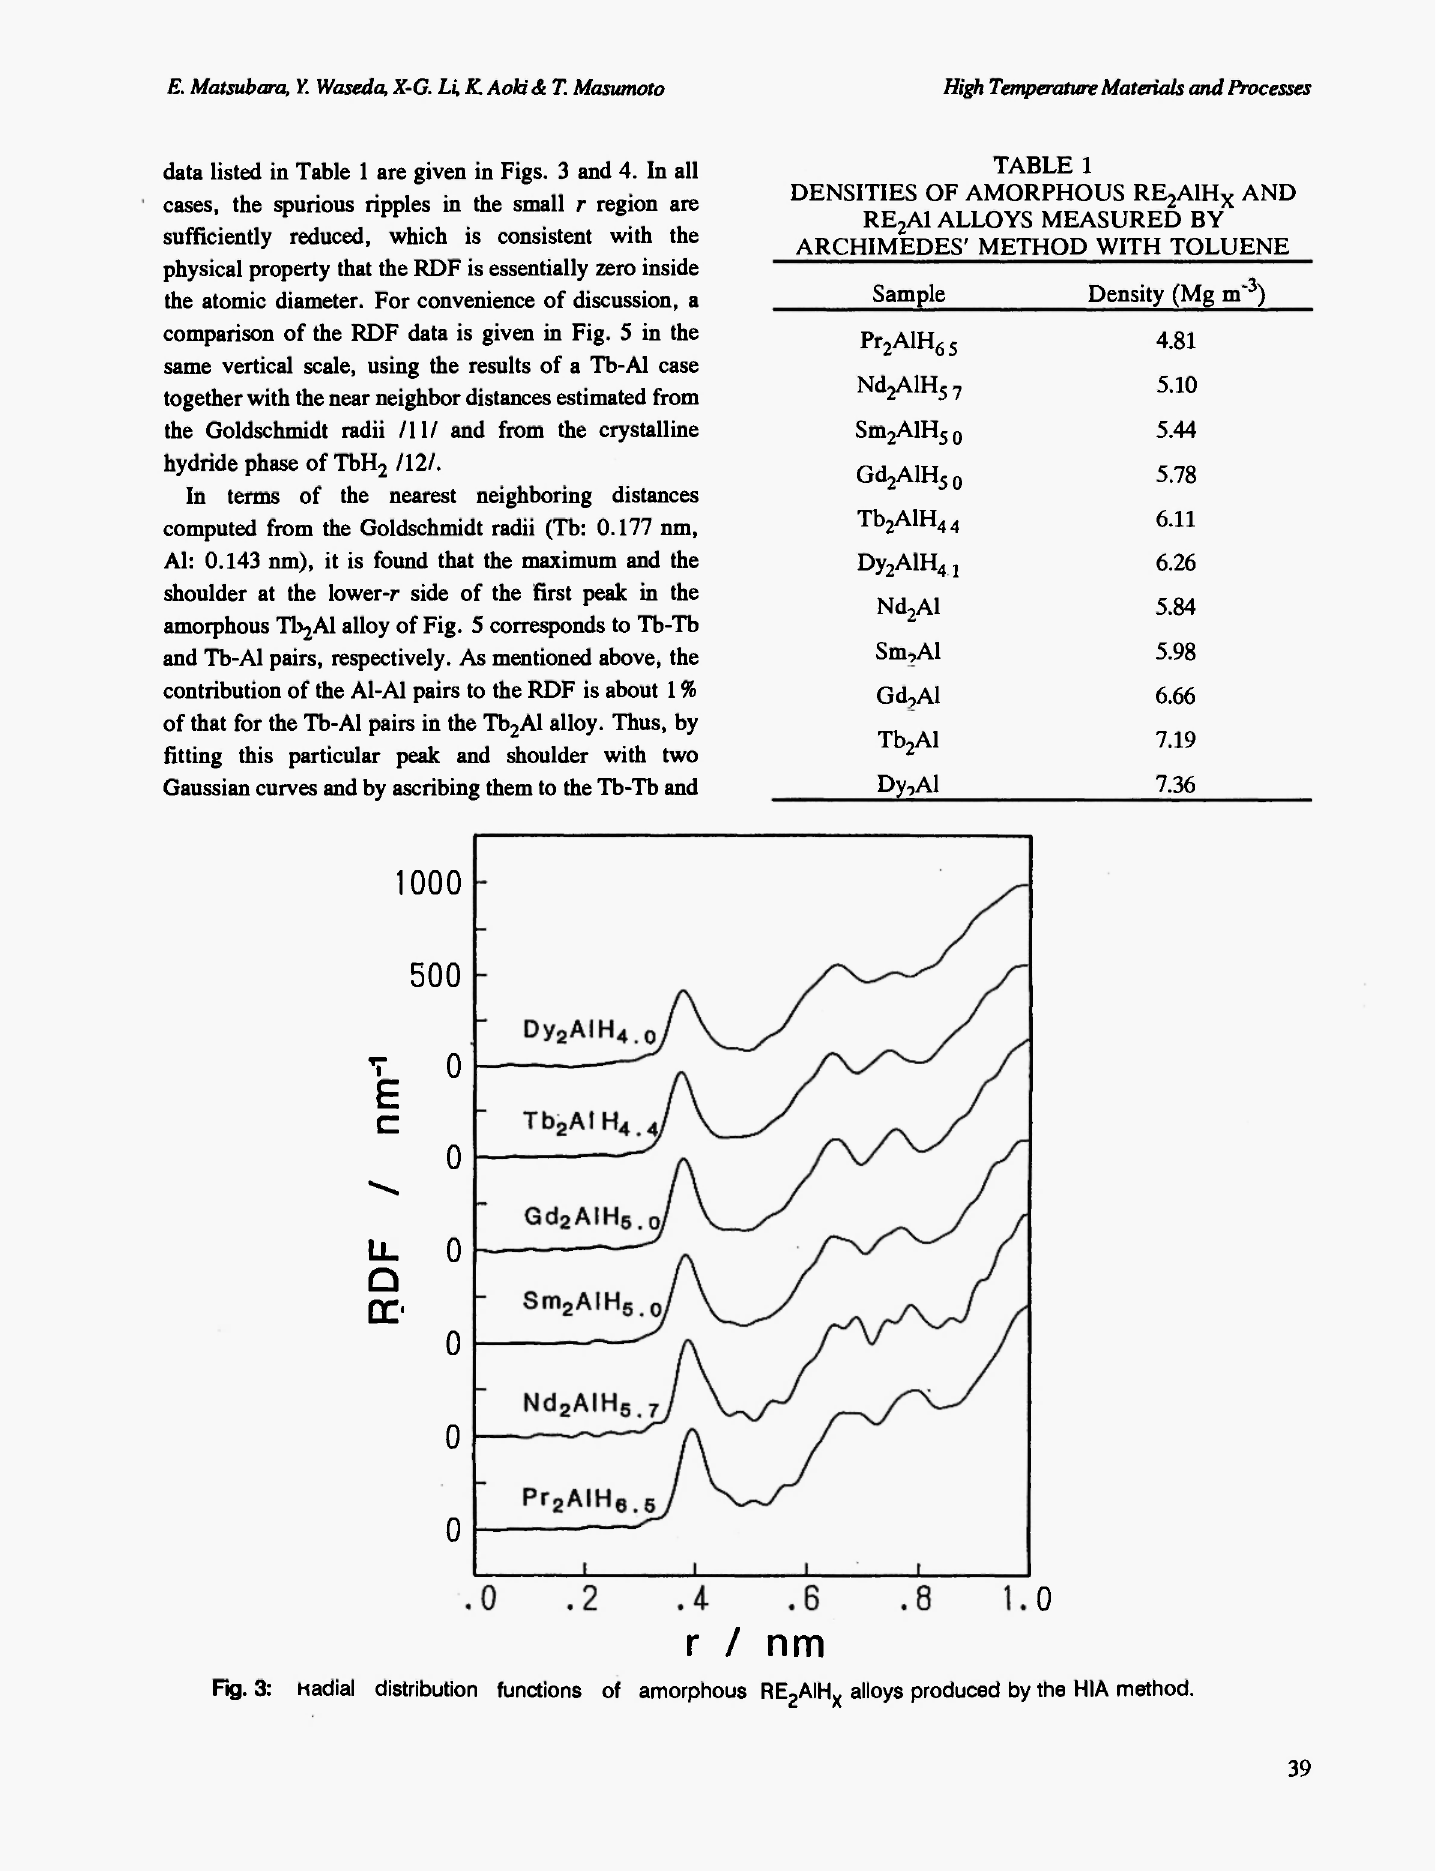
Fig. 3: hadial distribution functions of amorphous RE 2 AIH X alloys produced by the HIA